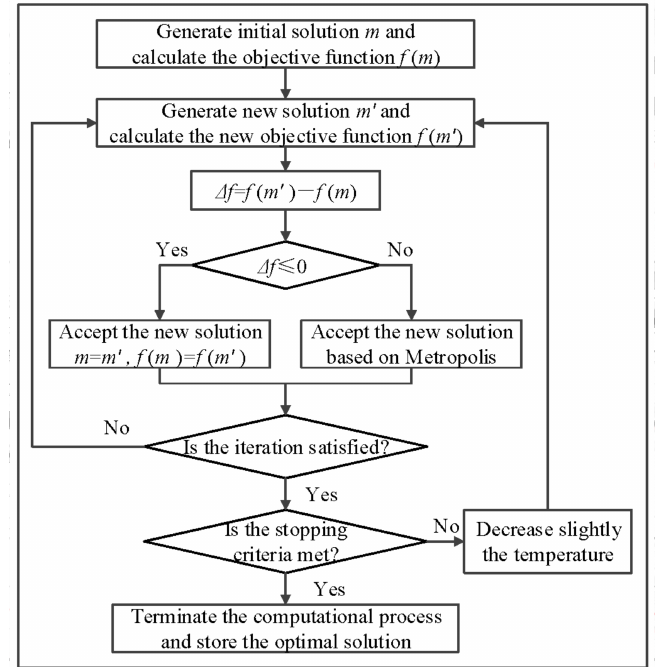
Figure 4. Flow chart of the simulated annealing